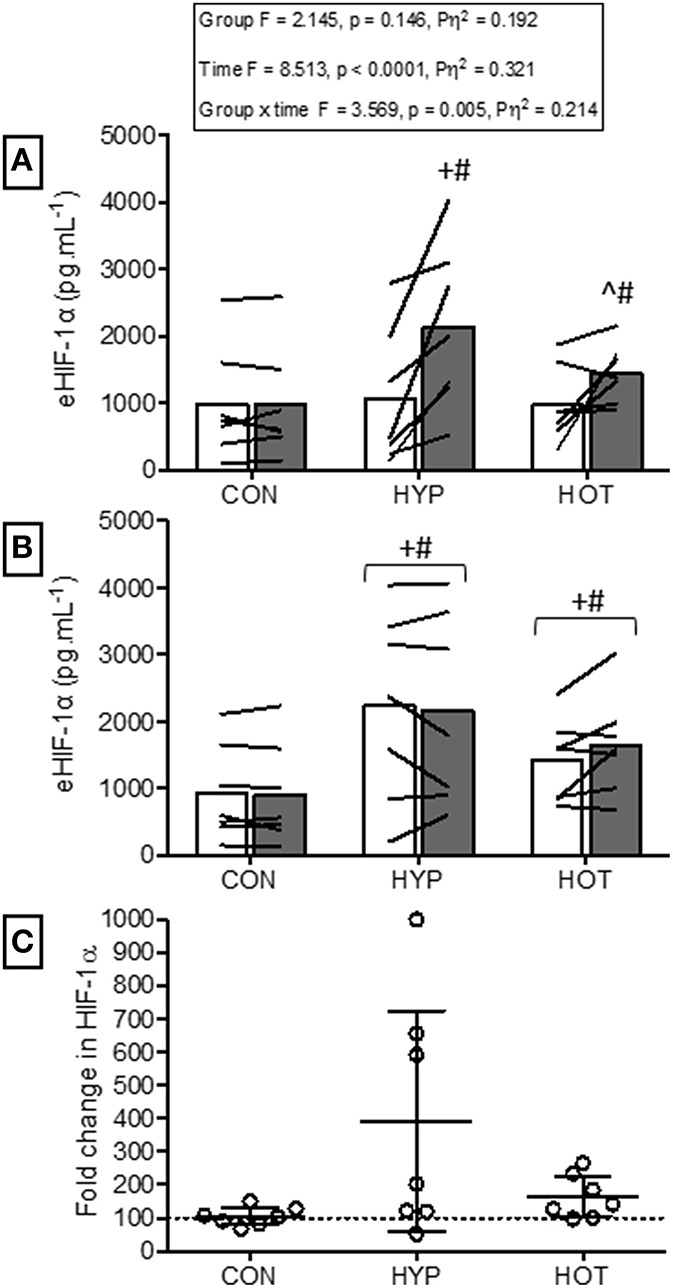
Extracellular HIF-1α responses before and after the acclimation period. (A) eHIF-1α is increased following an acute period of hypoxic exercise and is more variable following HOT. No post exercise changes in eHIF-1α were seen in CON (B) Resting eHIF-1α was elevated after 10 days of HYP and HOT acclimation, blunting the post exercise response on day 10 of acclimation. No changes in eHIF-1α were observed in CON. (C) The magnitude of change in resting eHIF-1α on day 10 of acclimation was no different between HYP and HOT. Open bars and shaded bars represent pre and post exercise, respectively. Lines (A,B) and dots (C) represent individual participant responses (n = 21) and bars the mean group response. The dashed line (C) represents baseline HIF-1α. +Different from day 1 rest (p < 0.05). #Different from control (p < 0.01). ^Different from day 1 pre exercise (p < 0.10). *Different from control (p < 0.05).